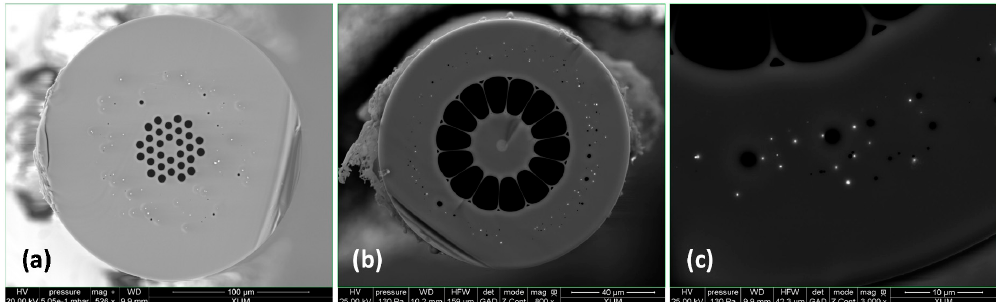
Figure 24 . SEM (in the backscattered configuration) pictures of cross-sections of two optical fibres with Pd particles embedded into the silica cladding realized by the powder in tube process: ( a ) a pure silica core microstructured fibre; ( b ) a SiO 2 -GeO 2 step index core with a microstructured cladding fibre; ( c ): zoom-in the cladding region of the fibre.